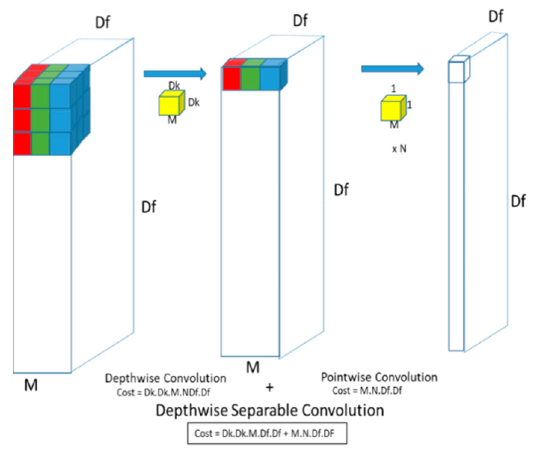
Figure 2. Depthwise Separable Convolution.